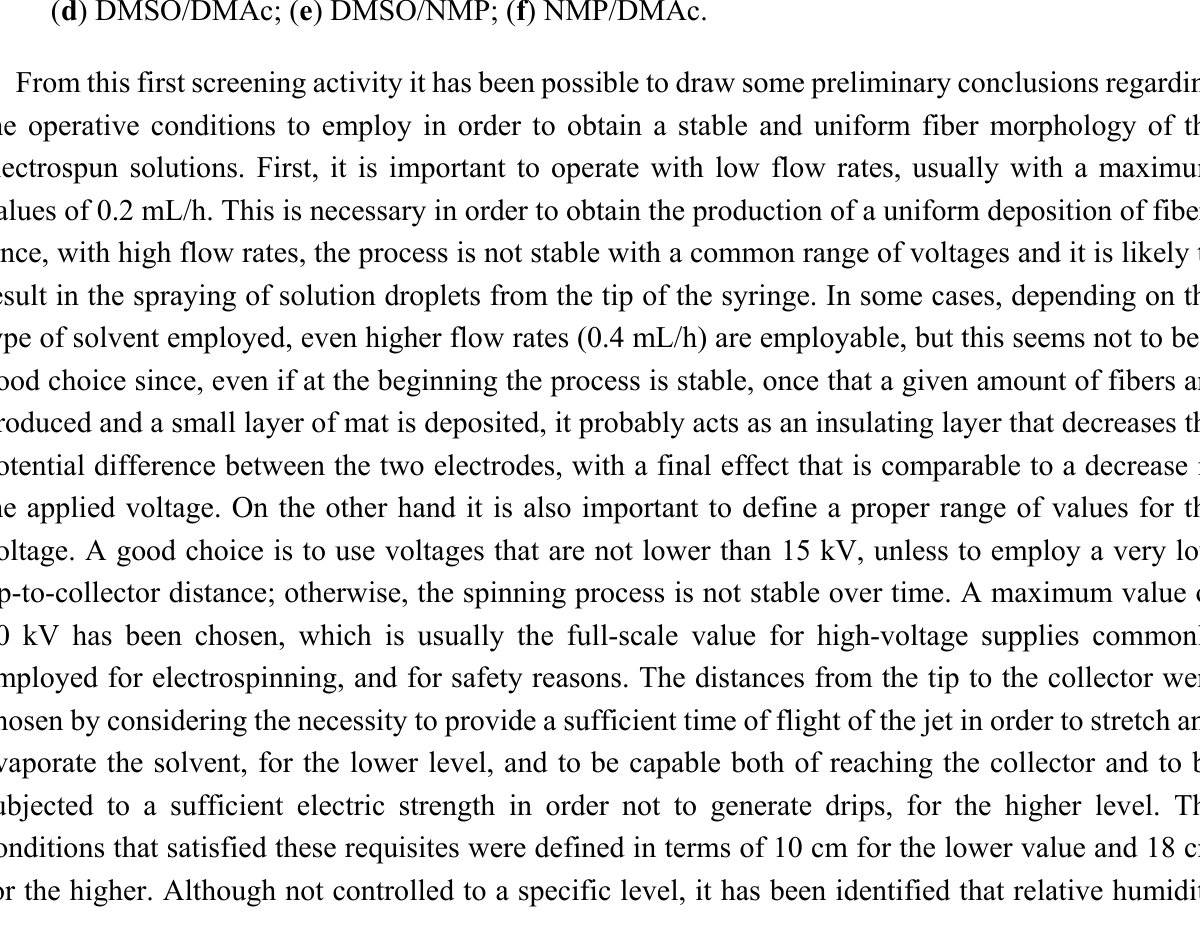
Figure 4. SEM micrographs of polymer solutions with binary mixture (50:50 w/w) of solvents (sulfonation degree DS ≈ 70%, electrospinning condition: voltage = 20 kV, distance: 14 cm, flow-rate: 0.125 mL/h): ( a ) DMF/DMAc; ( b ) DMF/DMSO; ( c ) DMF/NMP; ( d ) DMSO/DMAc; ( e ) DMSO/NMP; ( f )